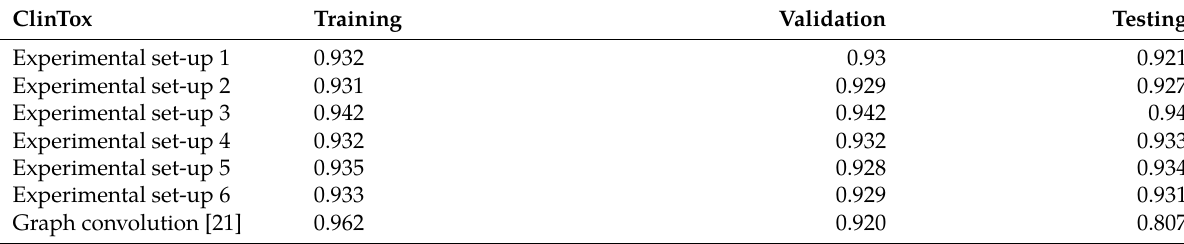
Table 3: Result for the ClinTox